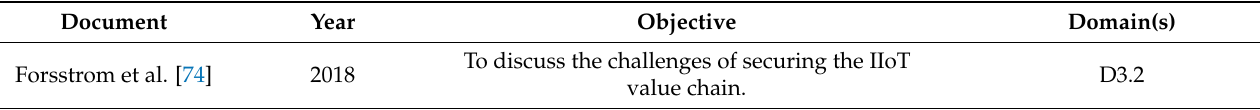
Table 6. Documents reviewed in the “Metrology of the Communication Systems for Digitaliza- tion”